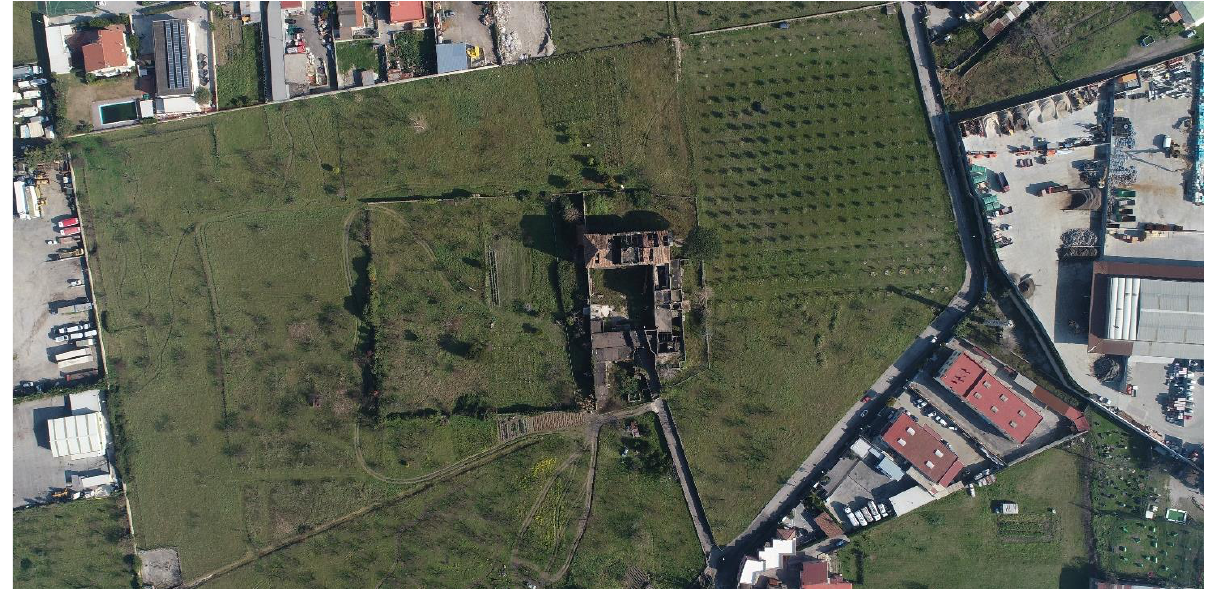
Figure 4. An aerial view of ‘Masseria Rota’ (M. Facchini, 2020).